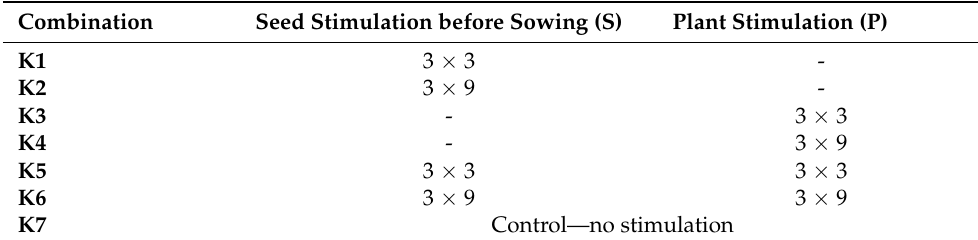
Table 1. Experimental